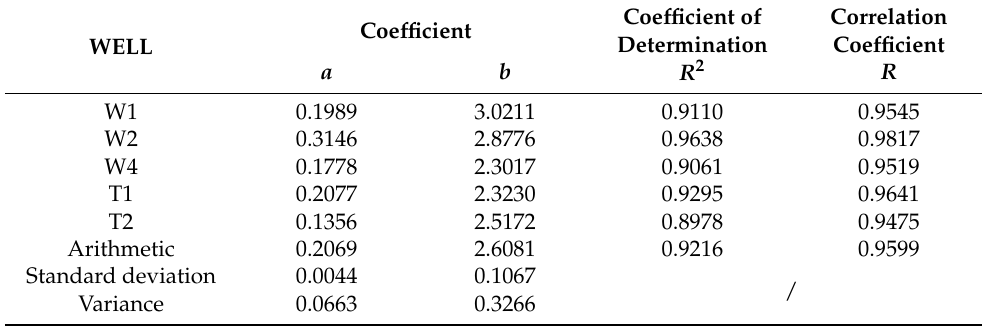
Table 1. Coefficient fitting of the resistivity–acoustic time difference